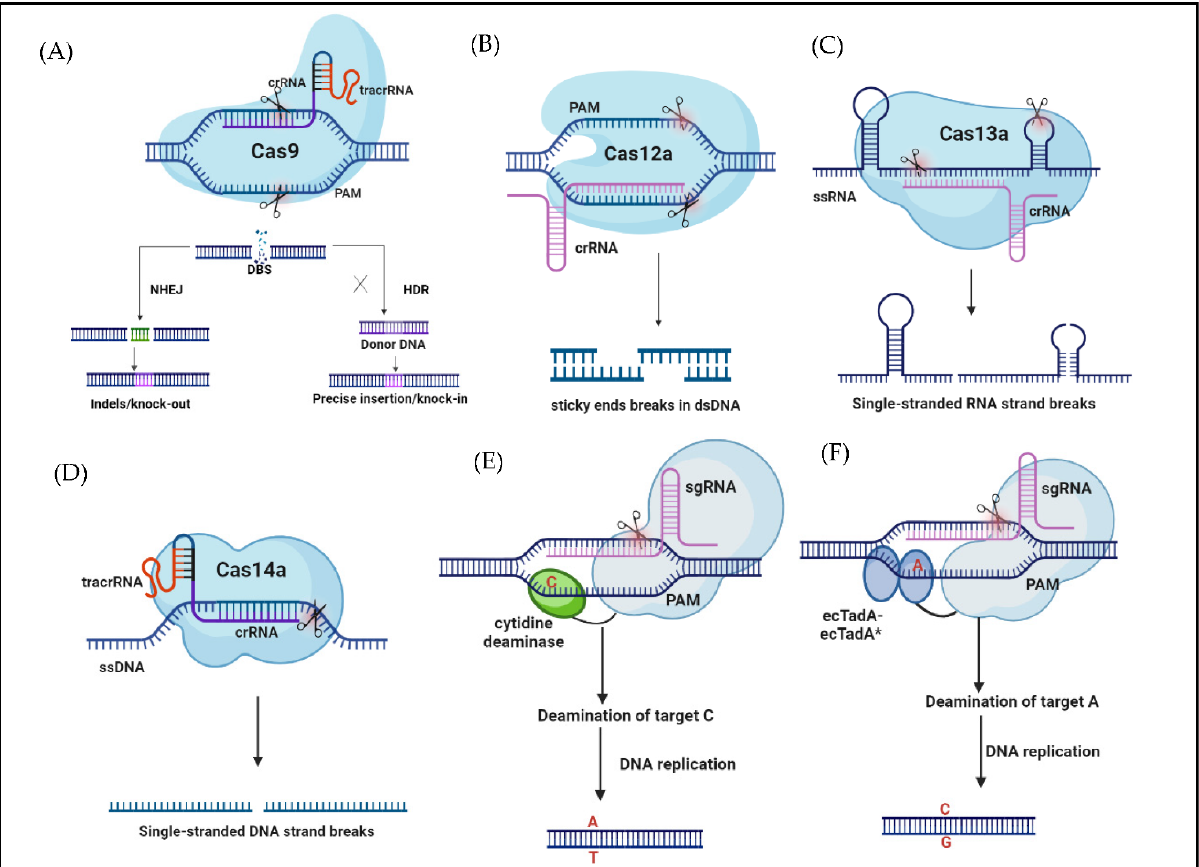
Figure 1. Representative schematic diagrams of CRISPR/Cas editing. ( A ) Cas9 applies the PAM and sgRNA to cleave the target DNA and produce a DBS, which is repaired by NHEJ or HDR; ( B ) Cas12a uses a RuvC domain under the guidance of crRNA without the participation of tracrRNA to cleave dsDNA, producing a sticky end; ( C ) Cas13a targets RNA in the nucleus; ( D ) CRISPR/Cas14a targets ssDNA cleavage under the direction of sgRNA, and does not require a PAM sequence, producing SSB; ( E ) CBE system compliments the single base replacement of the target site C-T (G-A), cleaves a single target locus, and produces a staggering cut; ( F ) ABE system compliments a single base substitution of A-G (T-C), cleaving at the targeted loci, and displaces the DNA fragment, leaving a staggering end in dsDNA (Provided by BioRender.com; accessed on 14 March